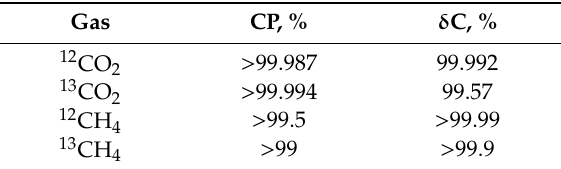
Table 1. Chemical purity (CP) and carbon isotopic enrichment ( δ C) of the studied carbon dioxide and methane gases.